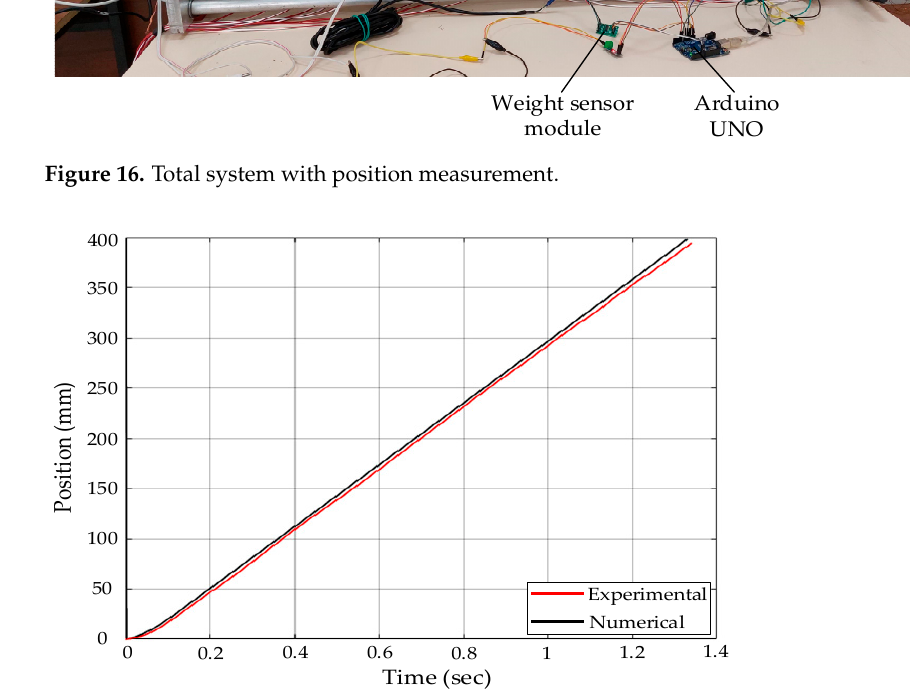
Figure 17. Time variations of positions for simulation and experiment.